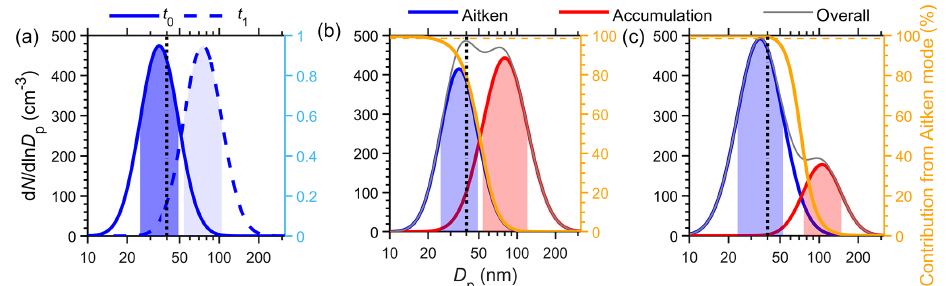
Figure 1. Matching aerosol Aitken mode with hygroscopicity measurements at fixed particle diameters. The dashed black lines indicate the selected particle size (i.e., D p , SCCN ) at which the hygroscopicity parameter κ is derived. The shaded areas indicate the 1 σ range from the fitted lognormal mode diameter, D p , n . Table 1. Hygroscopicity parameter κ of potential condensing species over remote oceans. Compound